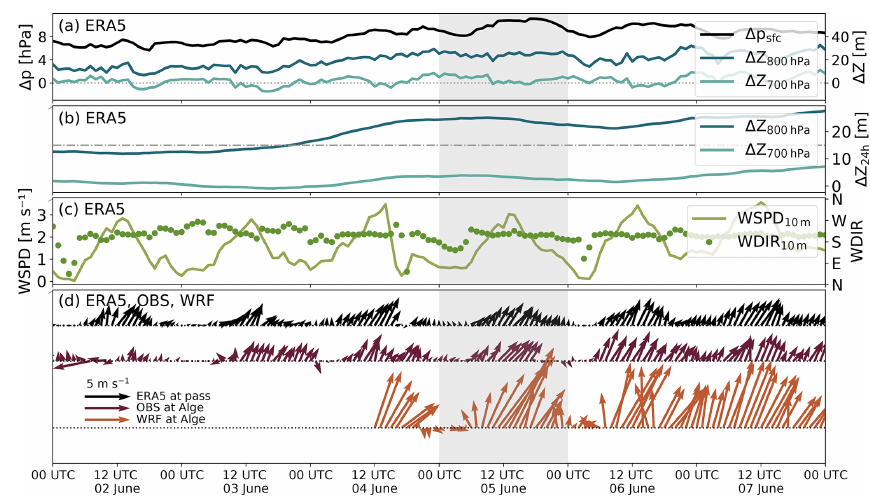
Figure 7. As in Fig. 3 but from 2 to 7 June 2018. Observations and simulated WRF winds are for the location Alge (AG; Fig. 1b, c). The period of the investigated gap flow event on 5 June 2018 is shaded in